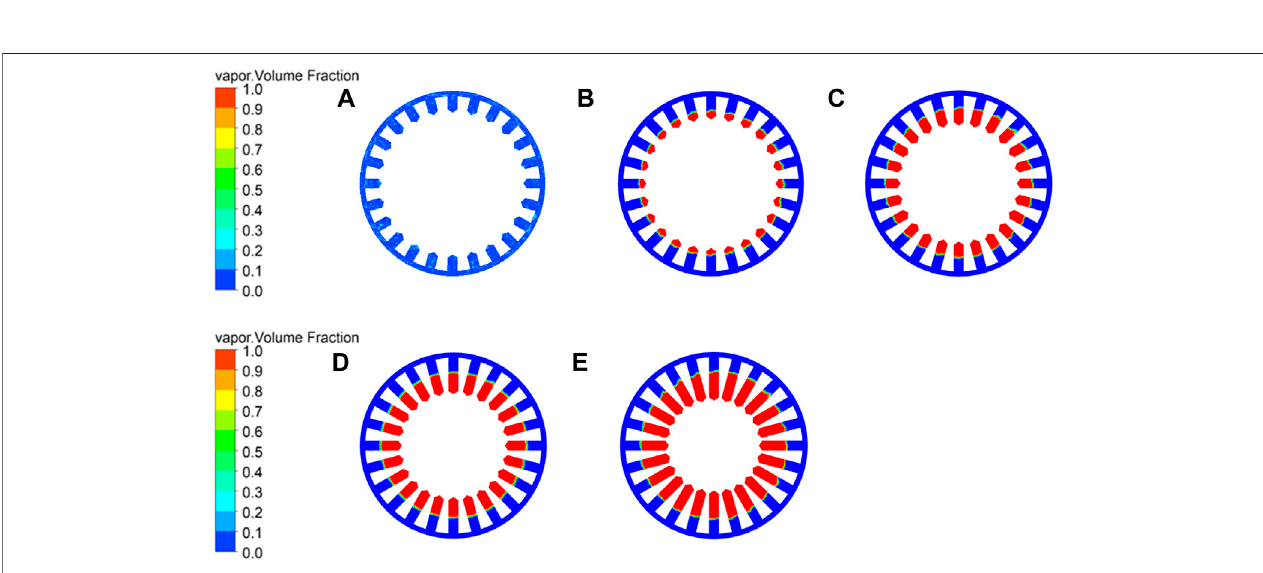
FIGURE 8 | :Vapor phase distribution with different heights: (A) H 1 = 25 mm, (B) H 2 = 35 mm, (C) H 3 = 45 mm, (D) H 4 = 55 mm, and (E) H 5 = 65 mm.